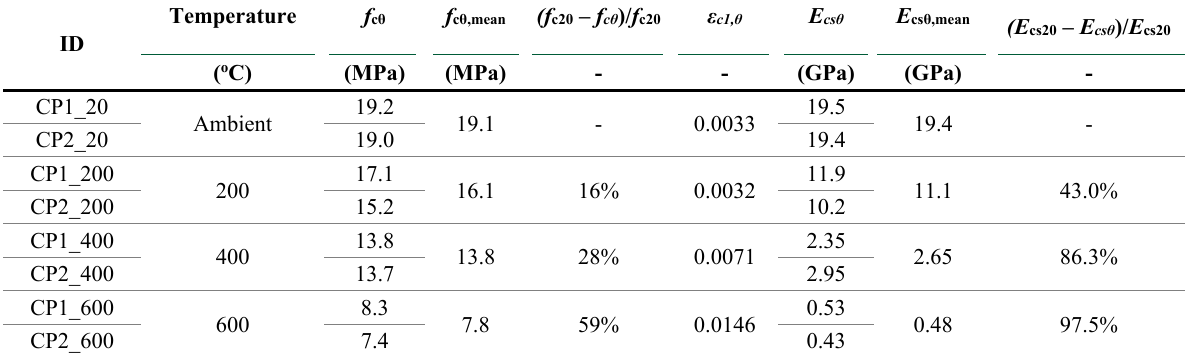
Table 1. Identification (ID) of specimens for Stage I and summary of